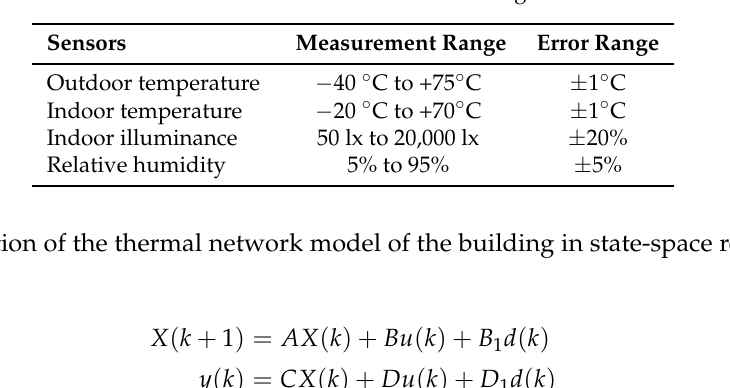
Figure 9. Equivalent thermal network model of the case study building. Table 4. Measurement and associated error ranges of